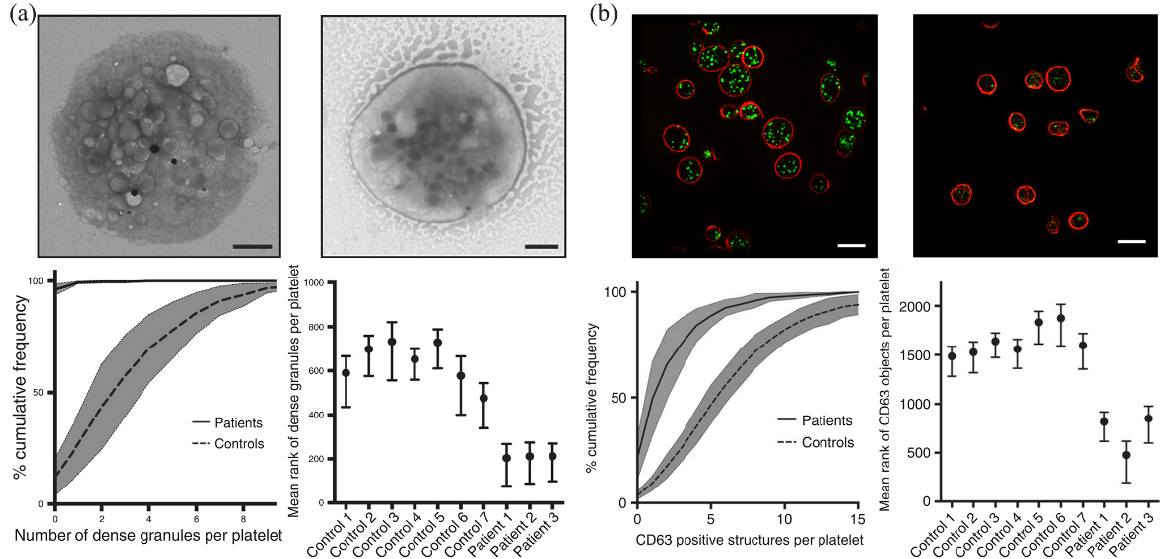
Figure 6. Detection and analysis of dense granules in platelets using EM ( a ) and SIM ( b ). Reprinted from [91].